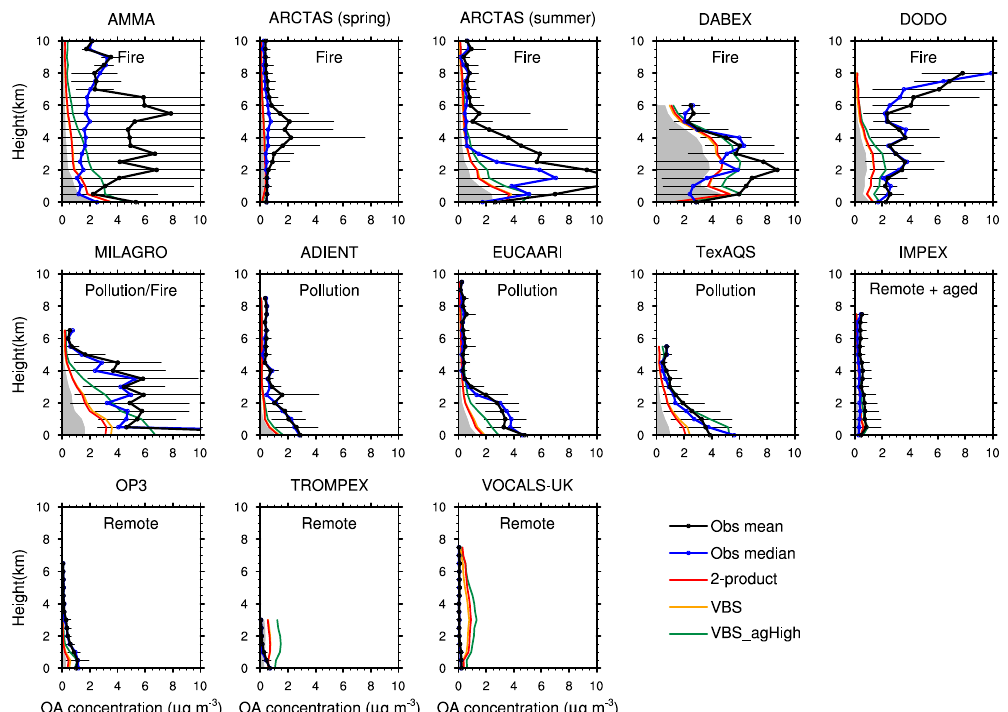
Figure 4. Comparison between the observed vertical profiles of OA concentration (µgm − 3 ) from 13 AMS field campaigns and the three model simulations: 2-product, VBS and VBS_agHigh. The campaign information is summarized in Heald et al. (2011) (Fig. 1 and Table 1 therein). The error bars are 1 standard deviation of the binned observations for each 0.5km interval. The grey shades are simulated POA assuming a POA-to-POC ratio of 1.4. The model simulations are sampled for the corresponding months and locations for each campaign. The location and location type for each campaign is included in each